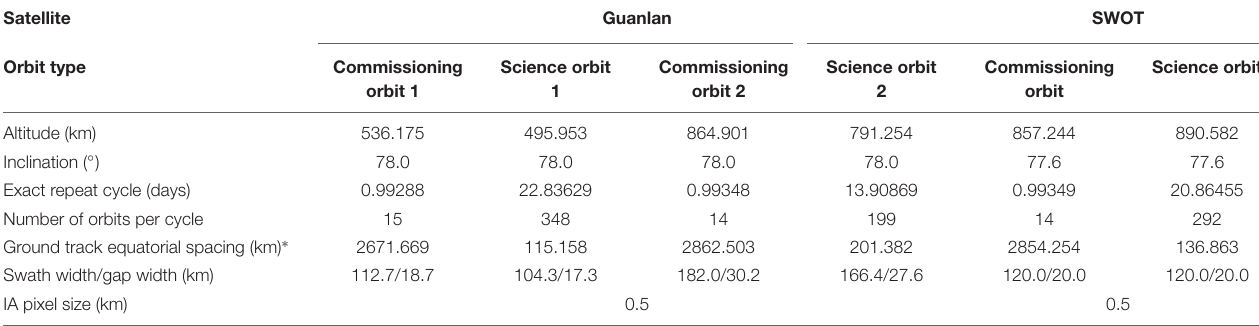
TABLE 2 | Orbit characteristics for Guanlan and SWOT.